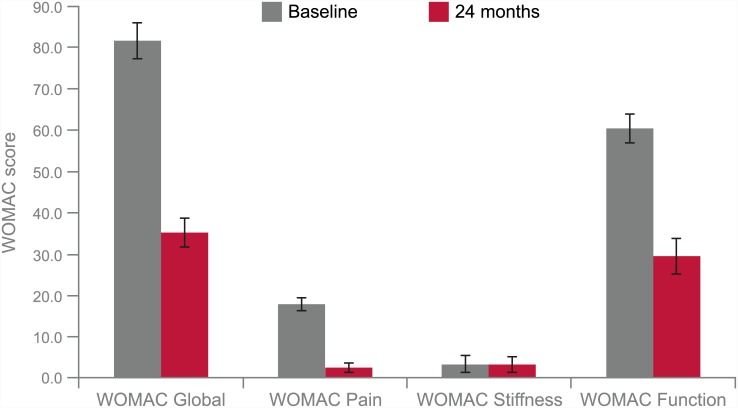
WOMAC global and WOMAC subscores pain, stiffness and function at baseline and 24 months after treatment with ACS and physiotherapy.Error bars denote standard deviation. ACS: Autologous conditioned serum; WOMAC: Western Ontario and McMaster Universities Osteoarthritis Index.